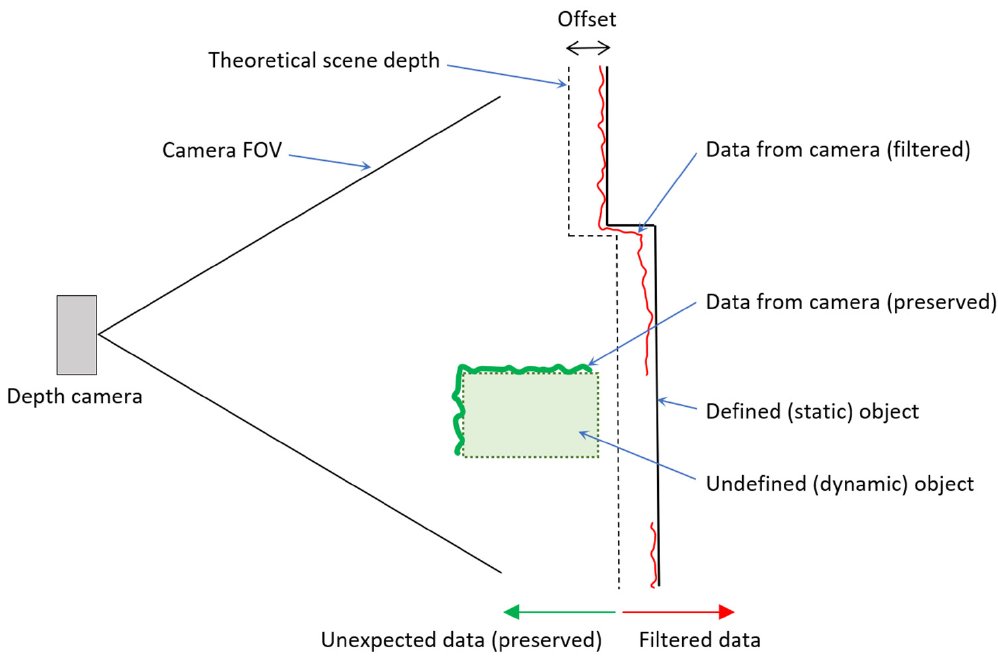
Figure 8. Illustration of filtration principle.